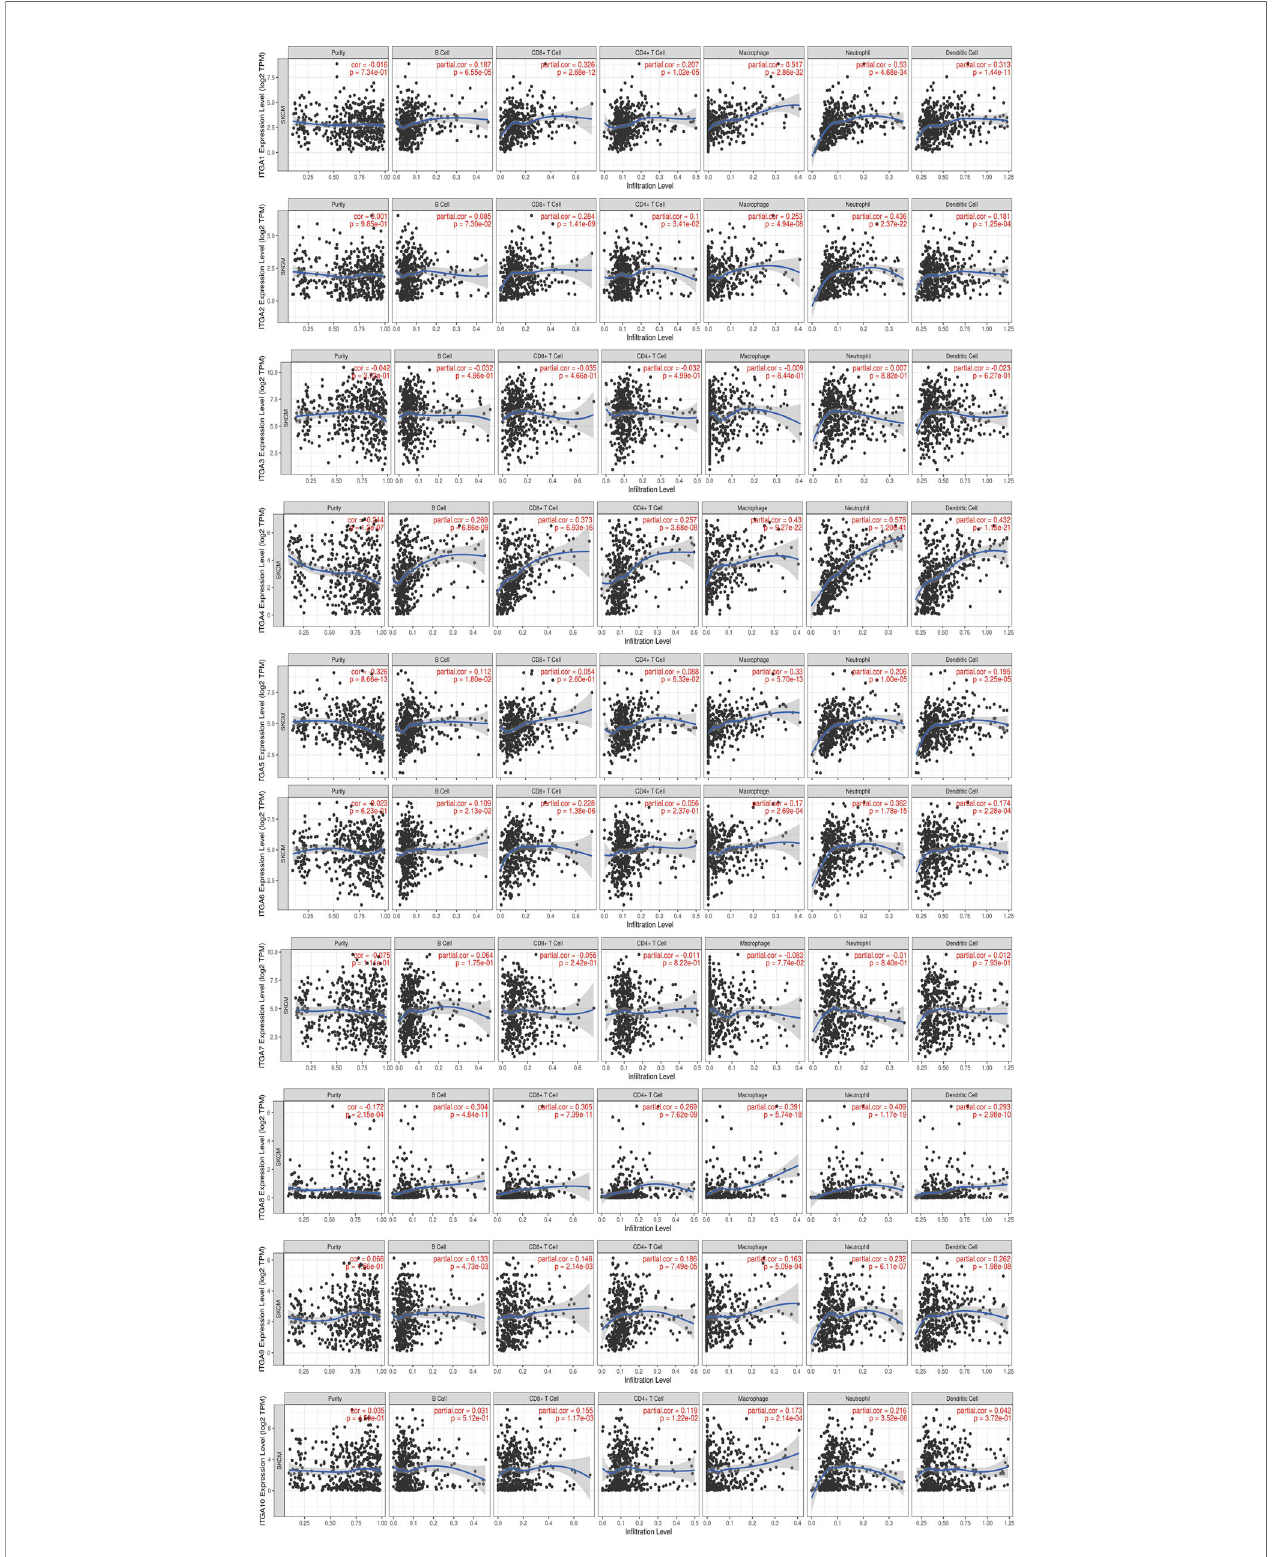
FIGURE 7 | Immune in fi ltration associated with ITGA1 – ITGA10 in SKCM patients (TIMER). Spearman correlation coef fi cient was used for statistical analysis. A P value less than 0.05 was used to determine statistical difference.